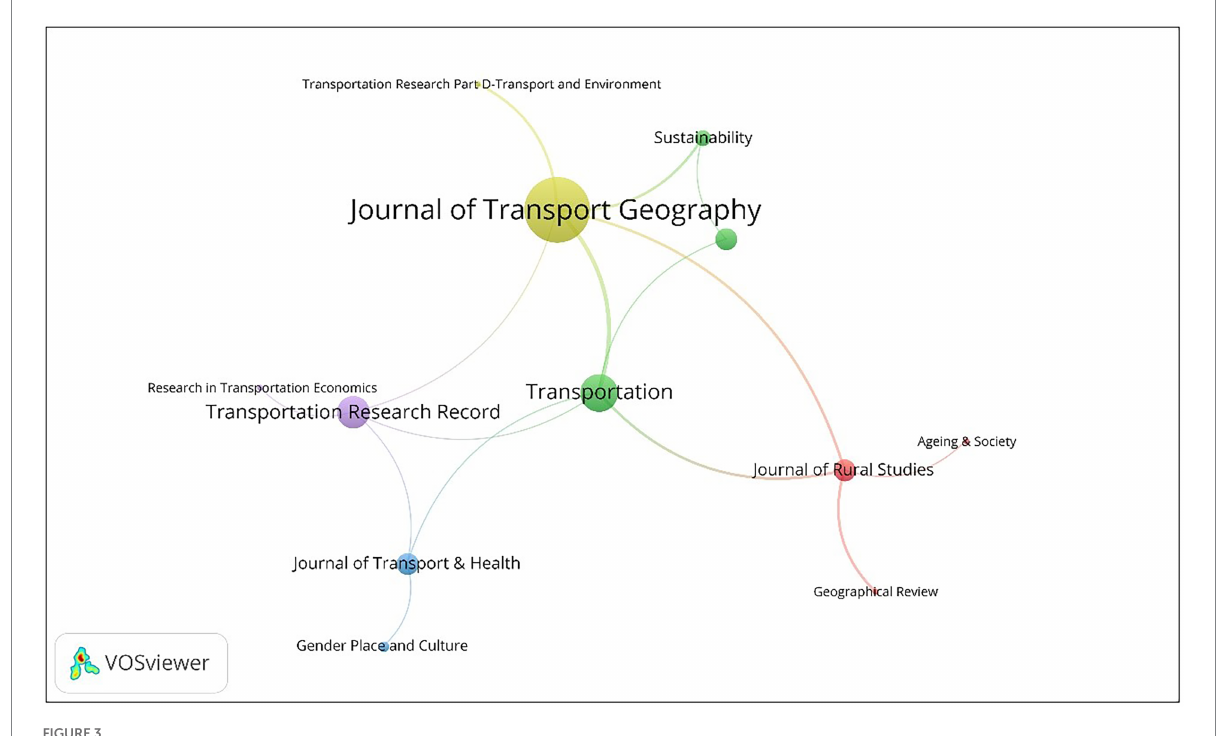
FIGURE 3 Map of mainstream journals in the field of rural travel